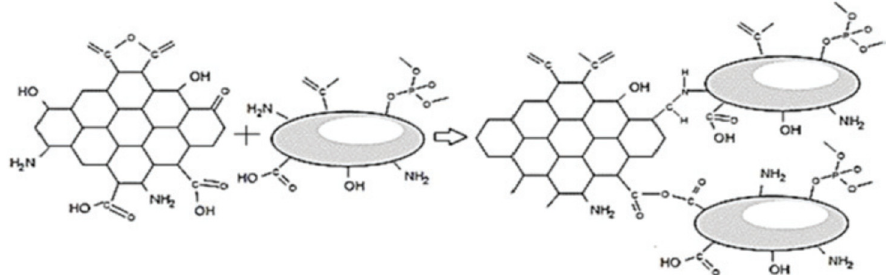
Figure 13. The formation of covalent bonds between the surfaces of microbial cells and the carbonized materials considerably contributes to the stability of the biocomposite materials. Reprinted with permission from Ref. [50]. Copyright 2020, Jenny Stanford Publishing Pte. Ltd.